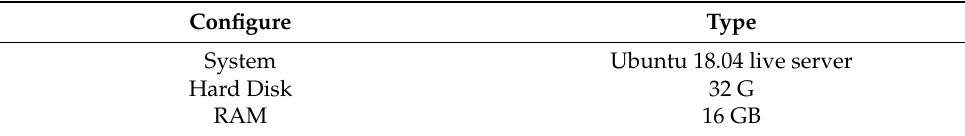
Table 1. Virtual machine